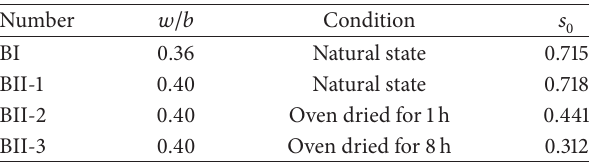
Table 3: Initial saturation of the specimens.